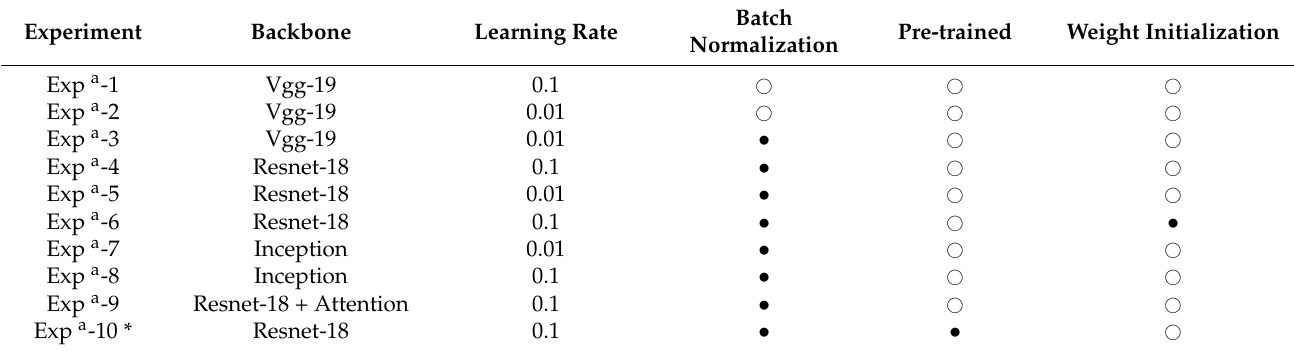
Table 1. Experiments settings of CNN models with different parameters adjusted